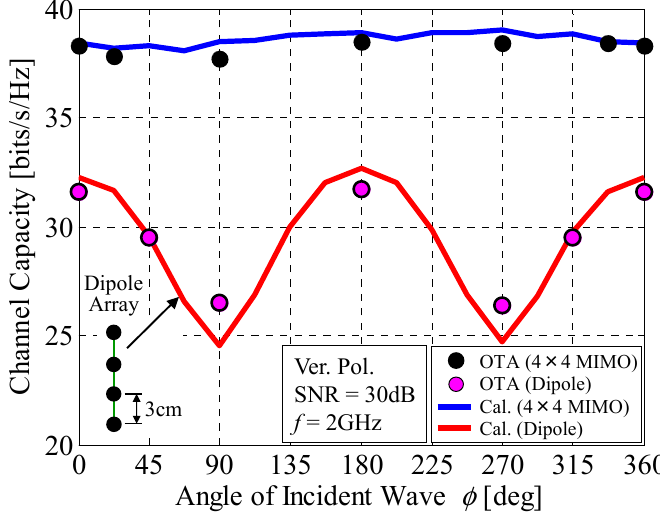
Figure 22. Channel capacity of a 4 × 4 MIMO array antenna measured by OTA testing.